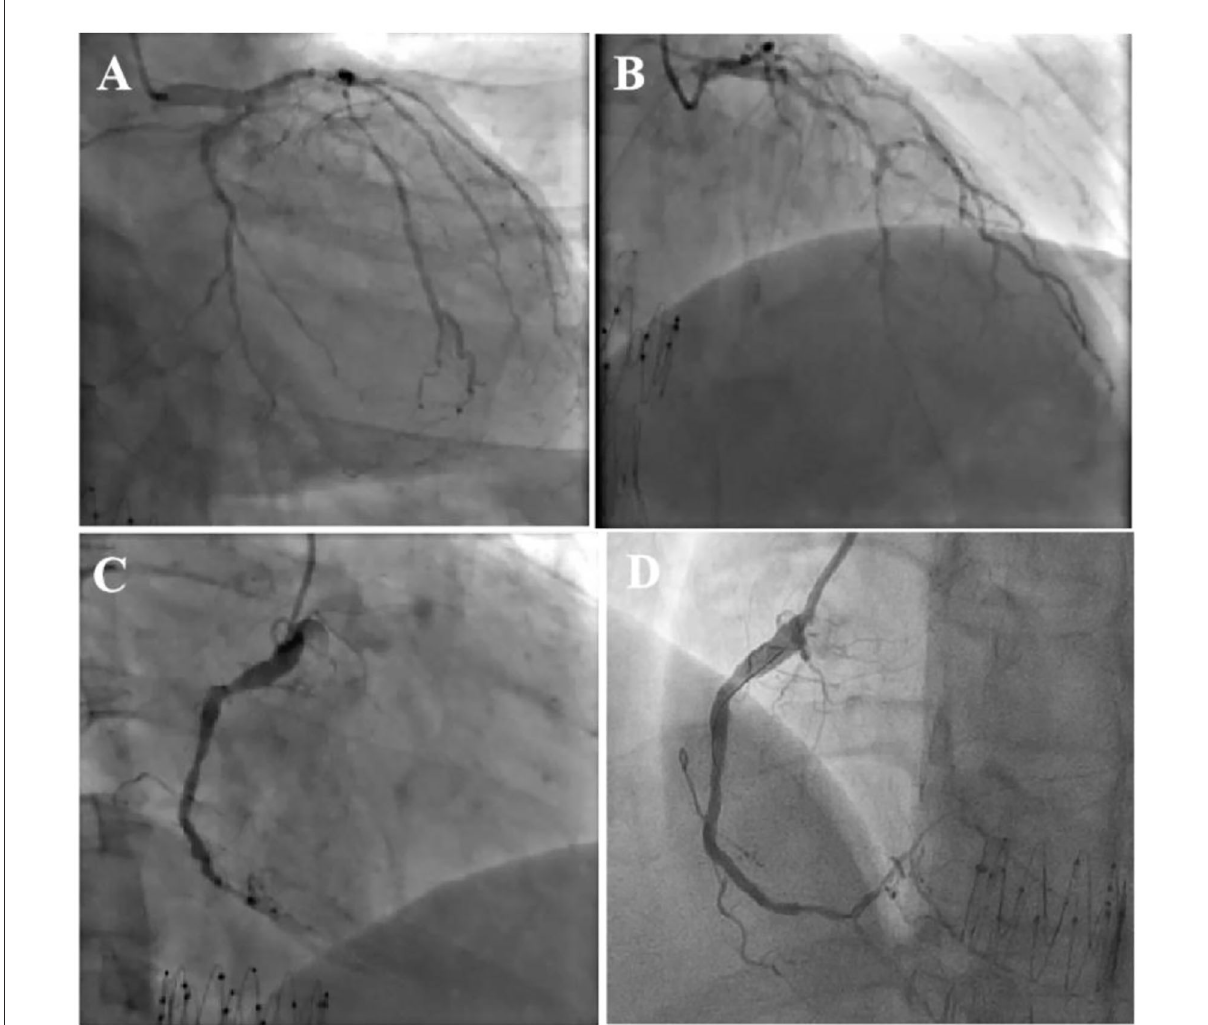
FIGURE2 Coronary angiography showed severe three-vessel coronary artery disease with severely diseased and calcified left circumflex artery (LCX) (A) and left anterior descending artery (LAD) involved in multiple segments (B) . RCA angiography unveiled fluent stent and diffused lesions in distal segment, and subtotal occlusion close to post-trigeminal area (C) , the distal lesion of RCA was treated with drug-coated balloon with satisfactory result (D) .